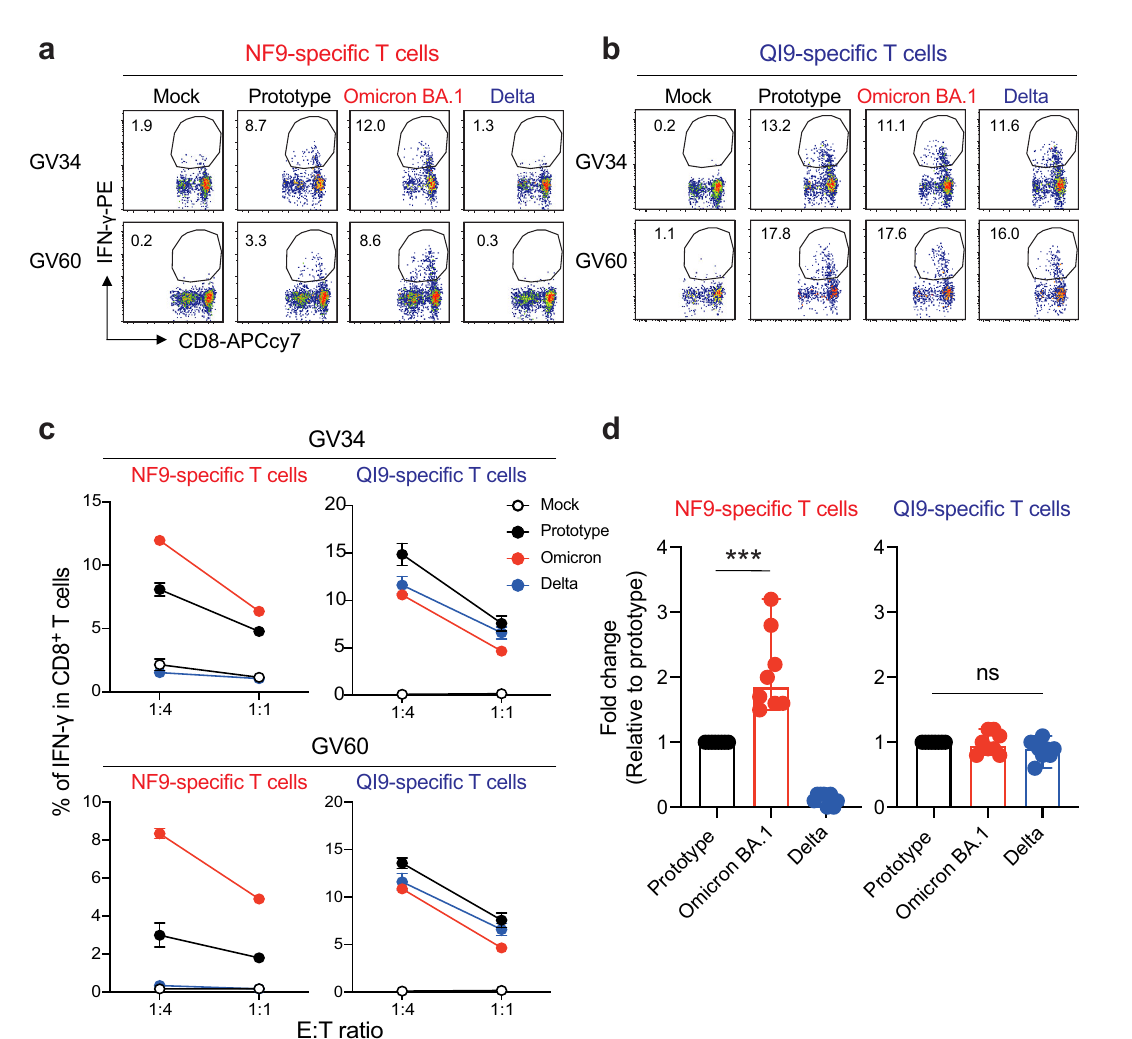
Fig. 1 | Detection of HLA-A*24:02-restricted antigen-speci fi c T cells in vacci- nated donors. a Binding of spike-derived epitopes to HLA-A*24:02 by HLA stabi- lization assay. b , c Detection of HLA-A*24:02-restricted antigen-speci fi c T cells in PBMCs by HLA tetramers. b Representative FACS plots showing tetramer + CD8 + T cells of an HLA-A24-negative vaccinated donor, GV17, and an HLA-A24-positive donor,GV16,before(upper)and aftervaccination(lower).SeealsoSupplementary Fig.1a(Gatingstrategy). c ThemedianofthepercentageofRF9/A24,NF9/A24,and QI9/A24 tetramer + CD8 + T cells. The median percentages of T cells in vaccinated HLA-A*24:02-positive donors ( n =30). The median percentages of T cells in vacci- nated HLA-A*24:02-negative donors ( n =5; GV4, GV12, GV17, GV25, and GV27) and non-vaccinated/seronegative HLA-A*24:02-positive donors ( n =5; GV16, GV32, GV33, GV34, and GV36) are shown as negative controls. d , e Detection of HLA- A*24:02-restrictedantigen-speci fi cT-celllinesinvitro. d RepresentativeFACSplots showing surface expression of CD25 and CD137 on the CD8 + T-cell subset of a